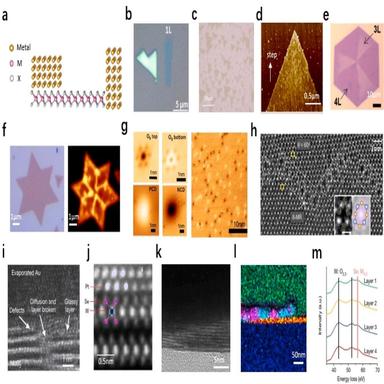
Channel in 2D materials-based electronics. a. Schematic diagram of two metal contact methods, top- and edge-contact b. OM image of mechanical exfoliated monolayer and multilayer MoS2. Copyright (2012), with permission from John Wiley and Sons. c. OM image of CVD grown monolayer MoS2. d. AFM image shows the relationship of CVD grown monolayer MoS2 and step direction of sapphire substrate. e. SHG image correlated to the polarizing optical image of 2H-MoTe2 (. Copyright (2018), with pe